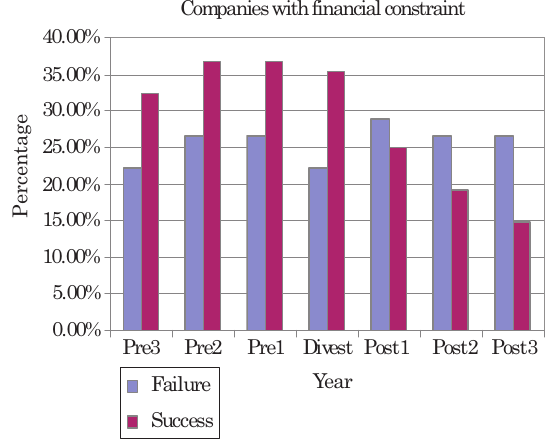
Companies with financial